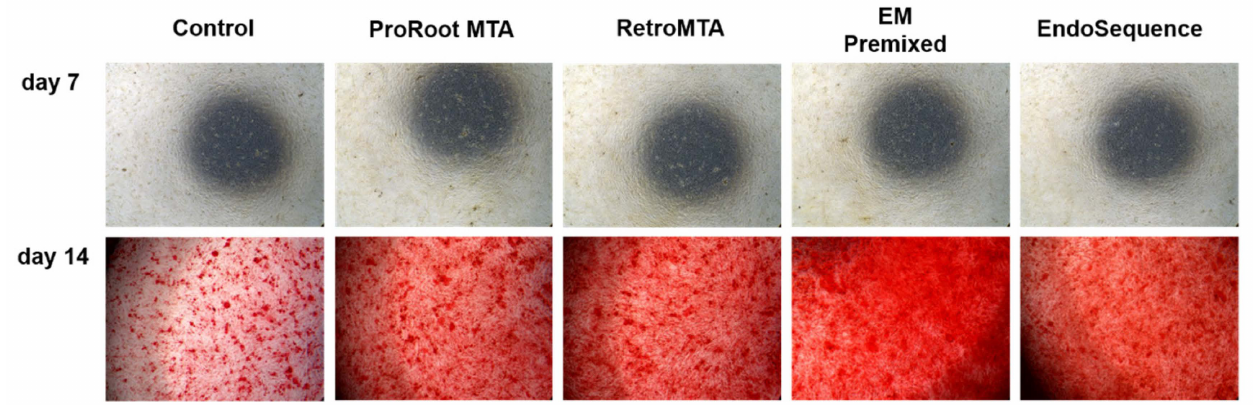
Figure 8. Representative images of Alizarin Red-S (ARS)